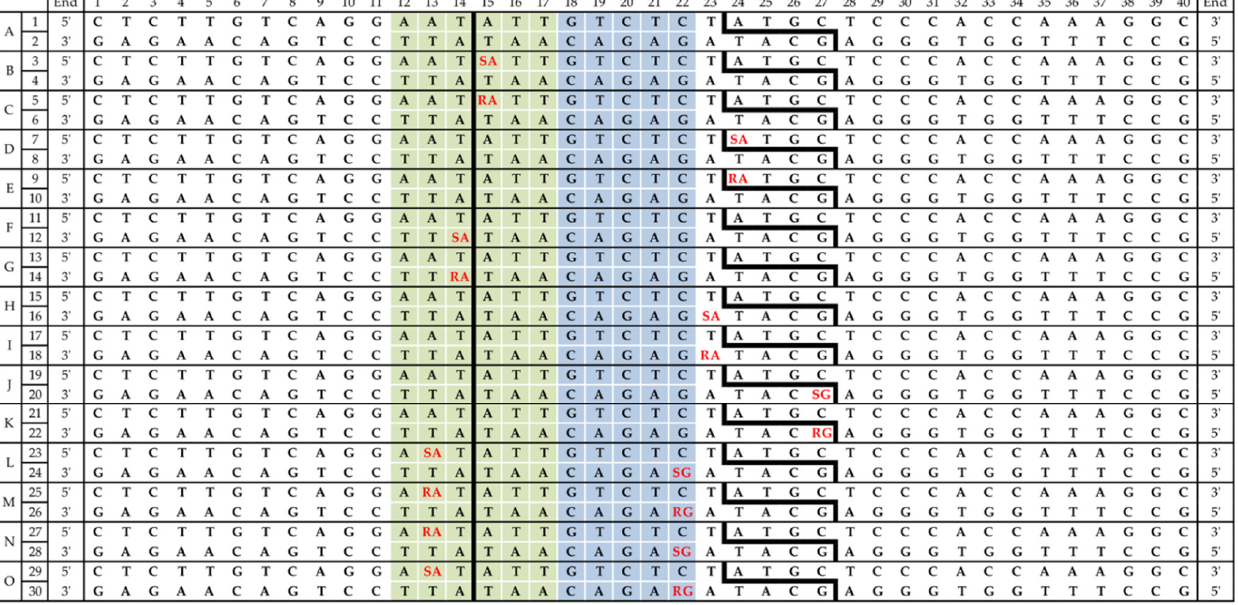
Figure 2. The sequences of substrate oligonucleotides containing 5 ′ ,8-cyclo-2 ′ -deoxypurines (cdPus). SX—(5 ′ S)-5 ′ 8-cyclo- 2 ′ -deoxyadenosine; RX—(5 ′ R)-5 ′ 8-cyclo-2 ′ -deoxyadenosine; SY—(5 ′ S)-5 ′ 8-cyclo-2 ′ -deoxyguanosine; RY—(5 ′ R)-5 ′ 8-cyclo- 2 ′ -deoxyguanosine.